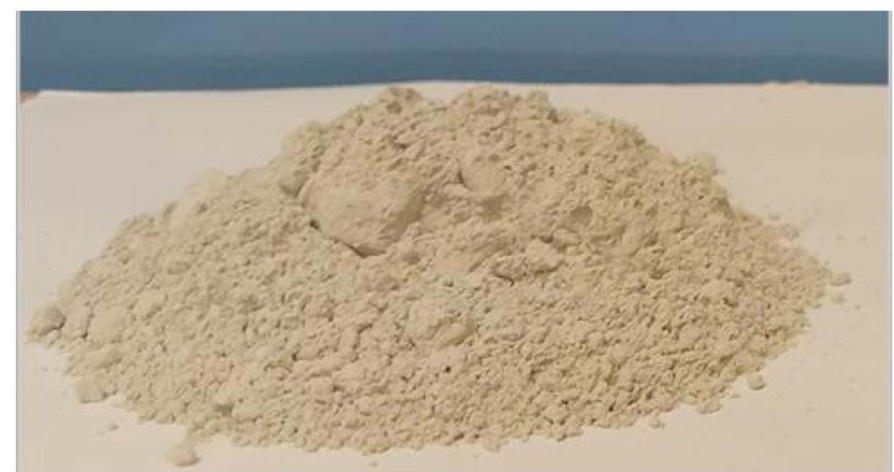
Table 1. Physical characteristics of WPSA and Figure 2. Particle size distribution for wastepaper sludge ash (WPSA).